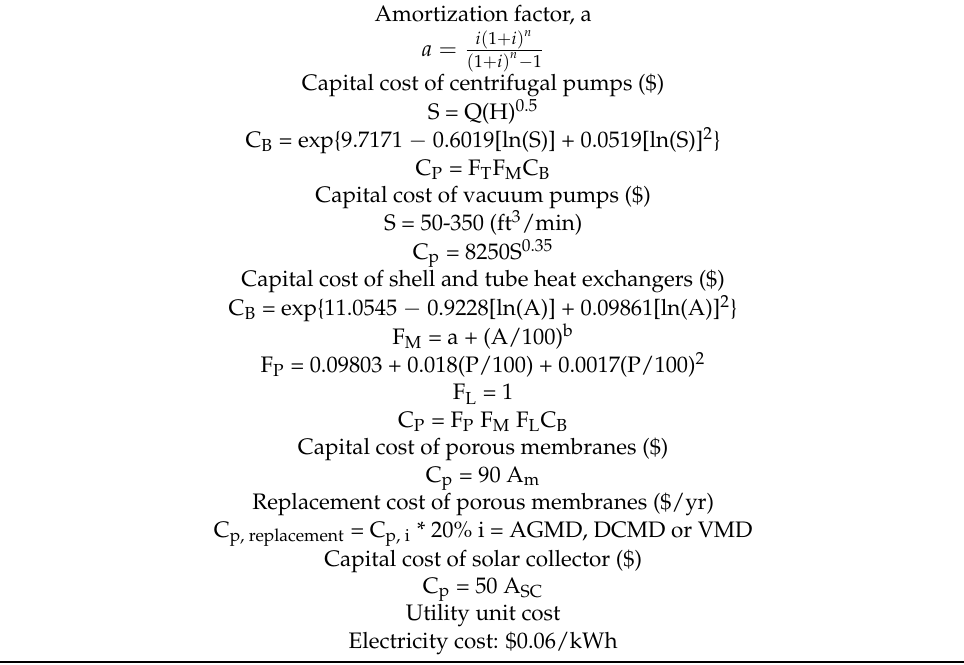
Table 4. Capital and operation costs of each unit of the SDMD system for desalination